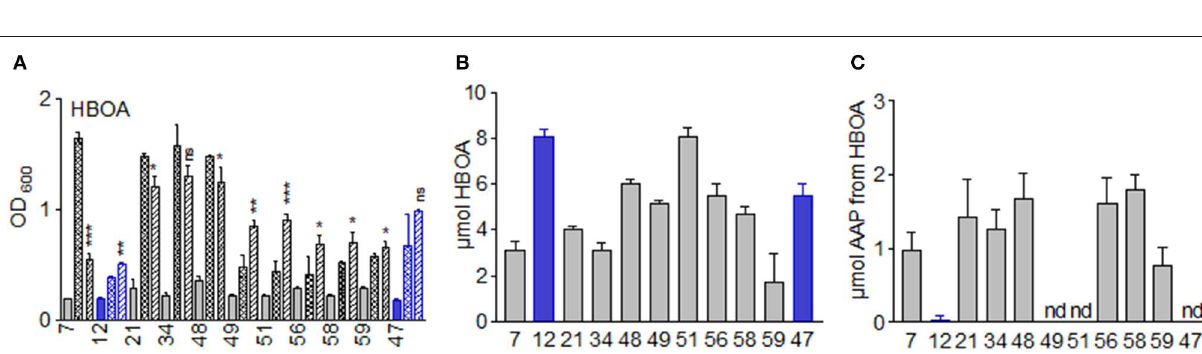
FIGURE 13 | Incubations of the microorganisms with HBOA. (A) Growth of the microorganisms in presence of 7.5 µ mol HBOA; OD 600 culture start, ; OD 600 after 72 h: control, ; OD 600 in presence of HBOA, . (B) residual amounts of HBOA after 72h of incubation with 7.5 µ mol HBOA. (C) accumulation of the HBOA degradation product AAP after 72h of incubation with HBOA. Microorganisms: Mycobacterium fortuitum (7), Bacillus aryabhattai (34), Bacillus cereus